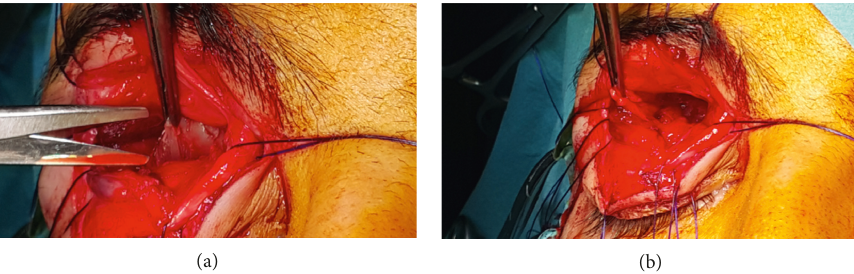
Figure 5: Intraoperative images. (a) By elevating the tumor, we bluntly dissect it carefully from the dorsal surface of the ocular bulb and from the optic nerve. (b) Demonstration of the surgical cavity after successful removal of the tumor.